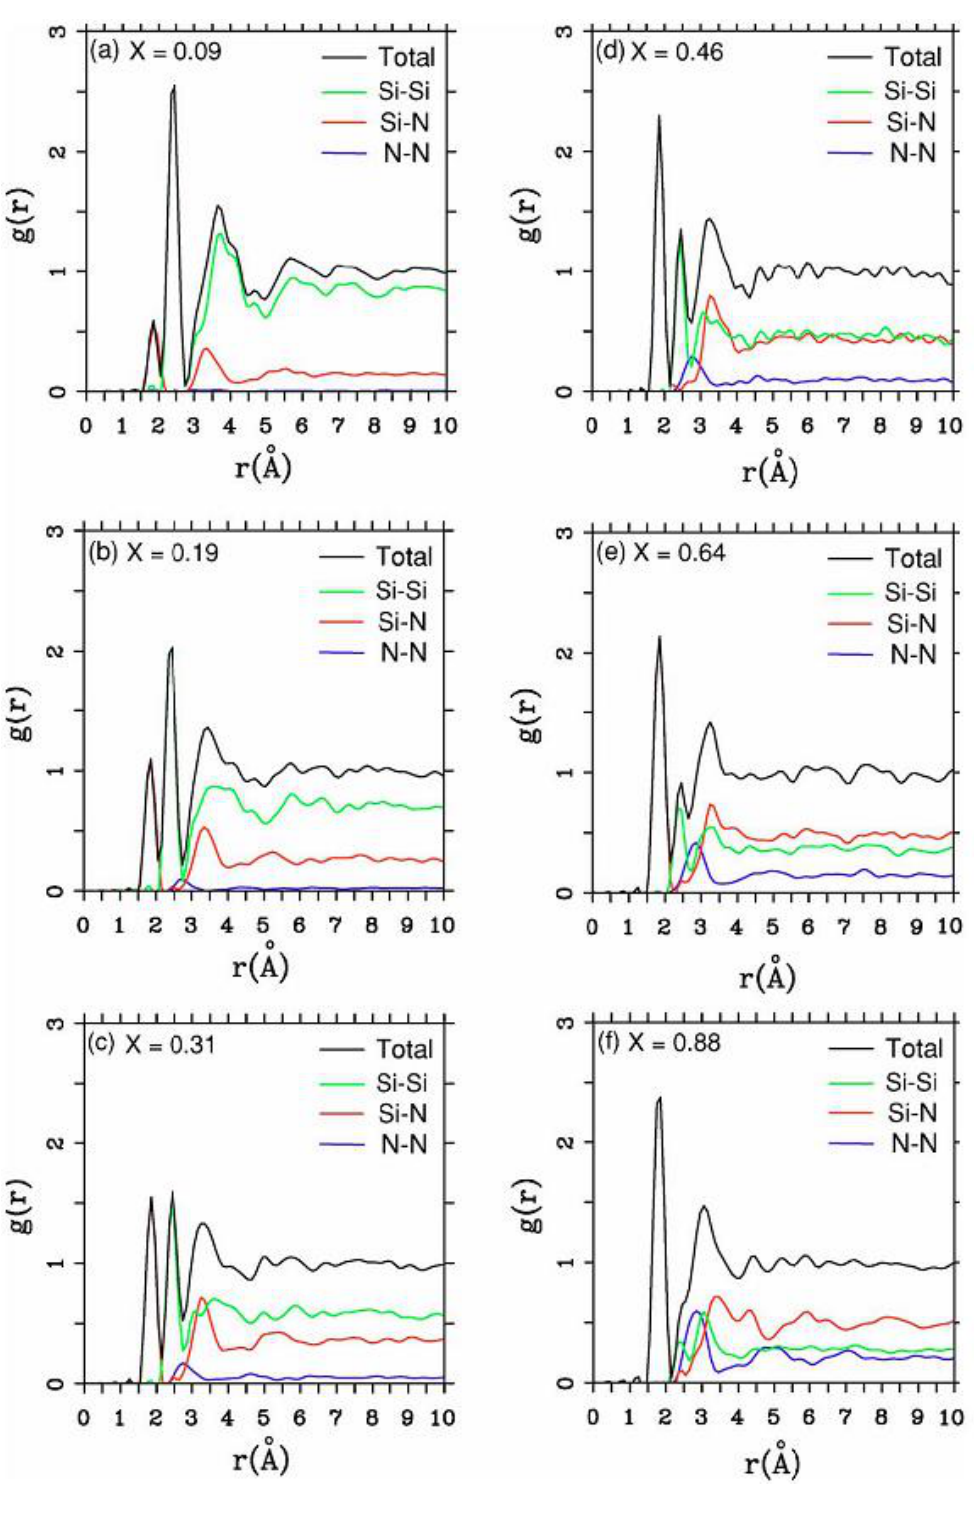
Figure 9. Total and partial RDFs for a -SiN . The contents are: ( a ) x = 0.09; ( b ) x = 0.19; x ( c ) x = 0.31; ( d ) x = 0.46; ( e ) x = 0.64; ( f ) x = 0.88; ( g ) x = 0.94; ( h ) x = 1.00; ( i ) x = 1.07; ( j ) x = 1.13; ( k ) x = 1.21 and ( l ) x = 1.29 (the